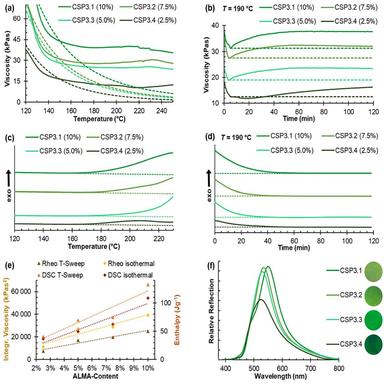
Analysis of the temperature stability of CSP with different ALMA content in the interlayer. The ALMA content is depicted in brackets behind the respective batch. (a) Temperature-dependent rheological examinations in ambient atmosphere in terms of dynamic complex viscosities. In a temperature range from 35 ◦C to 165 ◦C measured viscosities were fitted to Arrhenius-Law and extrapolated for temperatures > 165 ◦C. (b) Isothermal rheological examinations in ambient atmosphere. The minimum viscosity after a homog